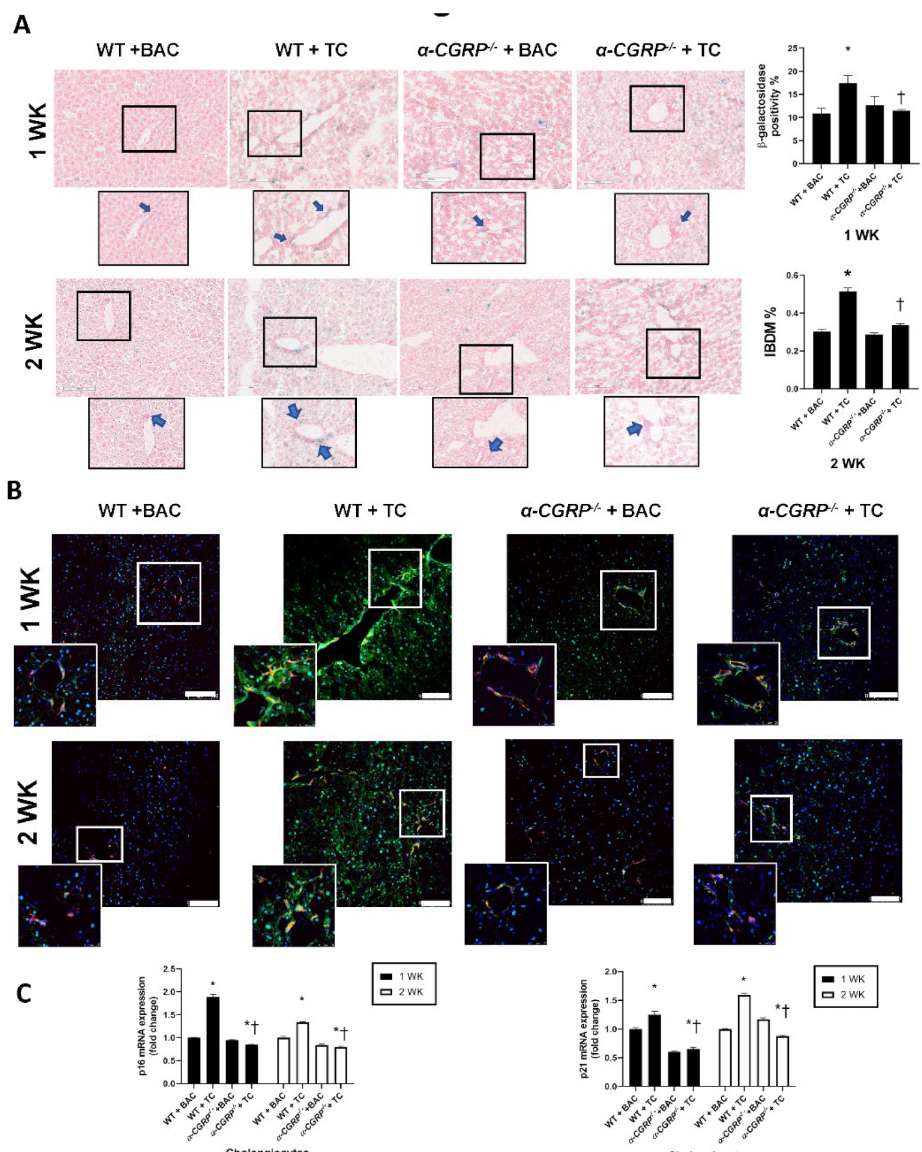
Figure 4. Biliary senescence is decreased in TC-fed α -CGRP − / − mice. ( A ) By SA- β -GAL staining and ( B ) immunofluorescence for p16 (co-stained for CK19, original magnification 20 × ; scale bar 100 µ m, white box: original magnification 80 × ). WT TC-fed mice displayed elevated biliary senescence compared to WT-fed BAC. TC feeding did not significantly increase biliary senescence in α -CGRP − / − mice compared to α -CGRP − / − mice fed BAC diet; no significant difference in biliary senescence was observed between WT and α -CGRP − / − mice fed BAC diet. Blue arrows show SA- β -GAL positivity in bile ducts. Original magnification 20 × ; scale bar 100 µ m. Black box: 40 × . Data are mean ± SEM of scanning slides from n = 3 different animals per groups. ( C ) mRNA expression of p21 and p16 in isolated cholangiocytes is significantly elevated in TC-fed WT mice, which is reduced in TC-fed α -CGRP − / − mice. Data are mean ± SEM of three evaluations from three cumulative preparations of cholangiocytes from five mice per groups. * < p value vs. WT + BAC; † < p value vs. WT +